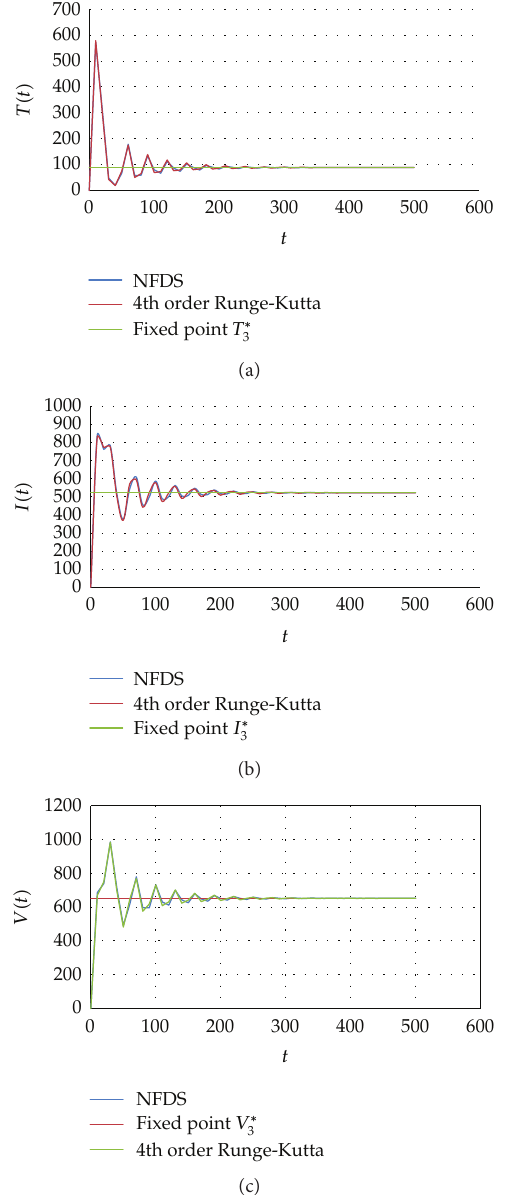
Figure 3: Comparison with NFDS and 4th order Runge-Kutta solutions for 𝐼(𝑡) , 𝑉(𝑡) , and 𝑇(𝑡) , 𝑟 = 3 .